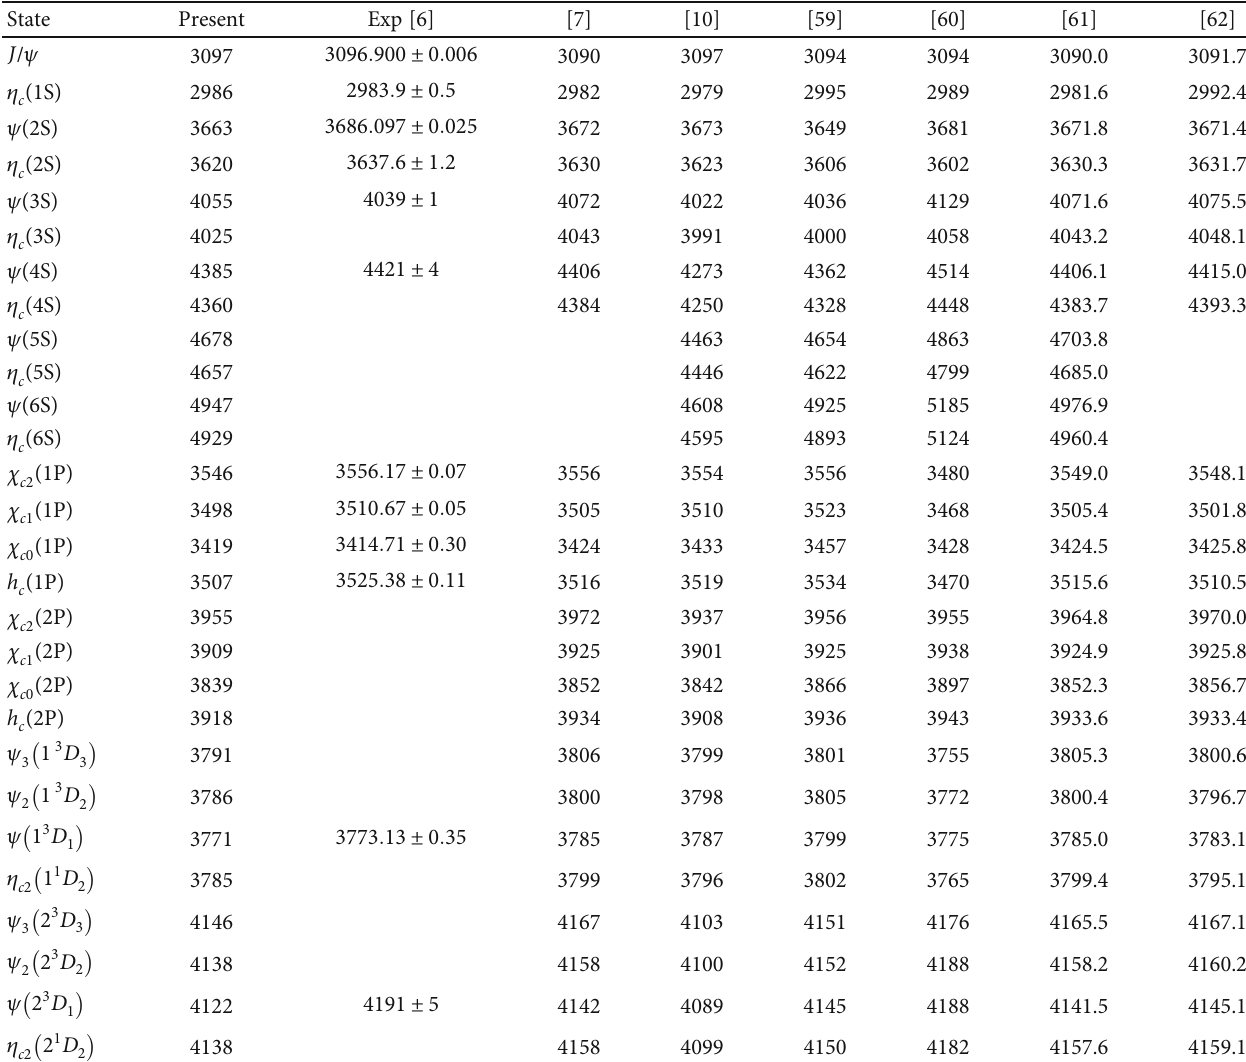
Table 2: Mass spectrum of charmonium states (in